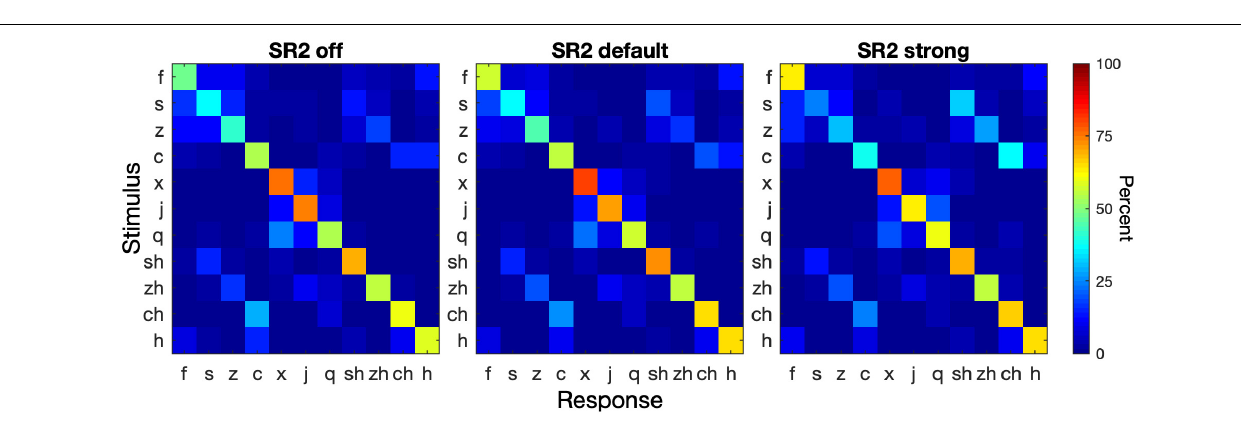
FIGURE 7 | Consonant confusion matrices. Consonant recognition data were collapsed from all 5 sessions. The three panels show the confusion matrices for SR2 off, SR2 default, and SR2 strong settings. In each panel, the stimulus is represented by the ordinate and the response by the abscissa. The color of each cell in a matrix represents the percent of a stimulus being identified as a particular consonant (see color bar on the